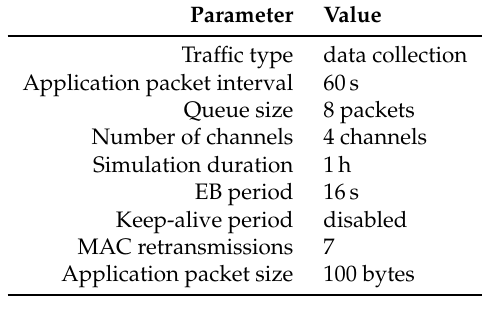
Table 2. Experimental parameters.